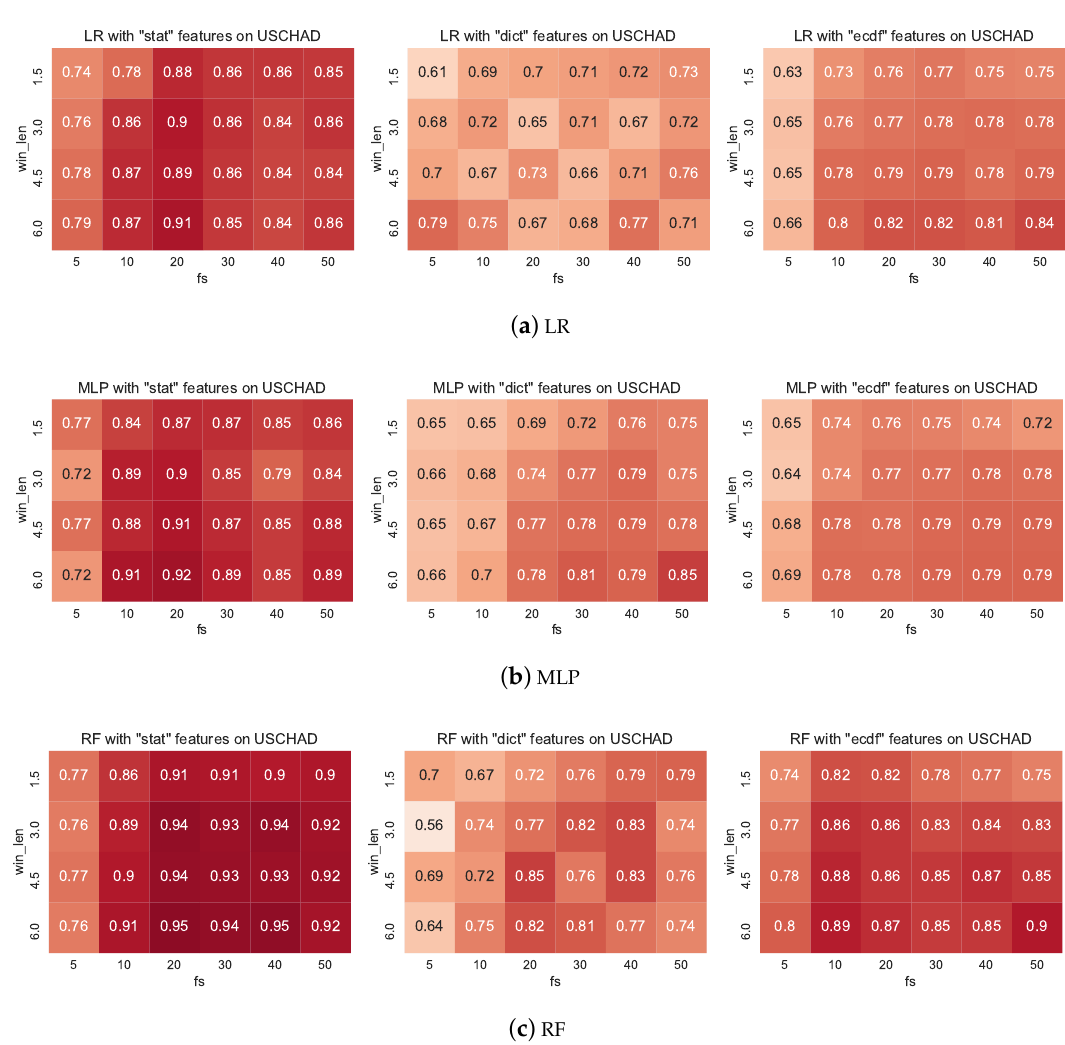
Figure A3. Classification performance on the USCHAD dataset with all iid feature